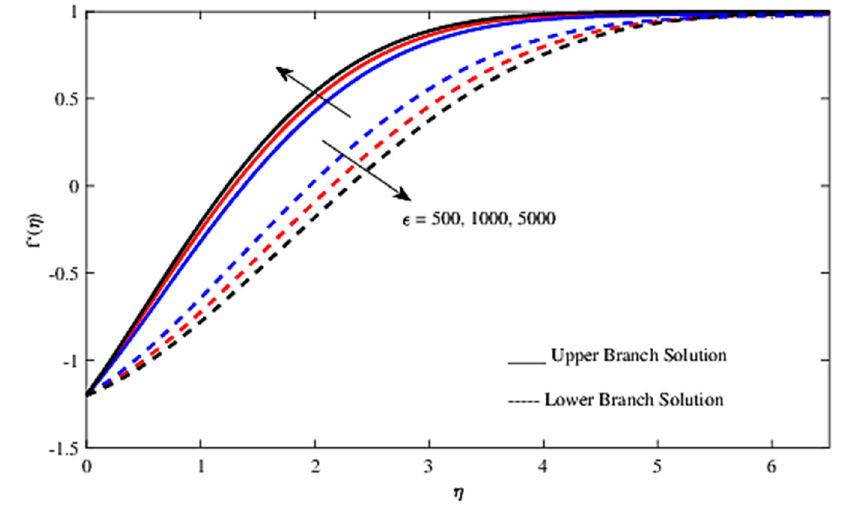
Figure 5. Velocity profiles ( ) f for several values of ε when λ = − 1.2, M = 0.5, Q = 0.1 and Pr = 1.0.